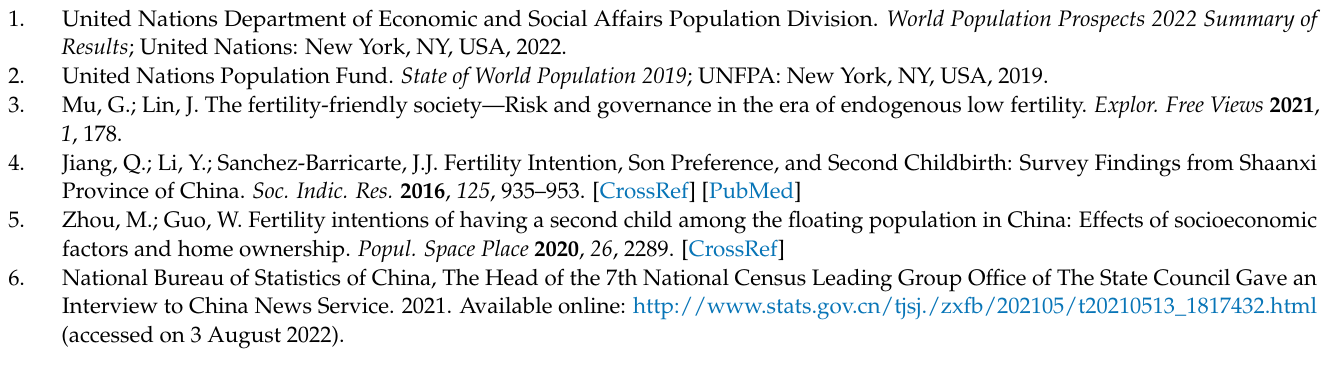
Table S4: Distribution of factors in 16 included studies. Table S5: Data extraction according to each factor. Table S6: Quality scores assessing risk of bias using a modified Newcastle-Ottawa scale; Table S7: Meta-analyses on 18 factors. Table S8: Factors not included in the meta-analysis and whether they were significantly associated with